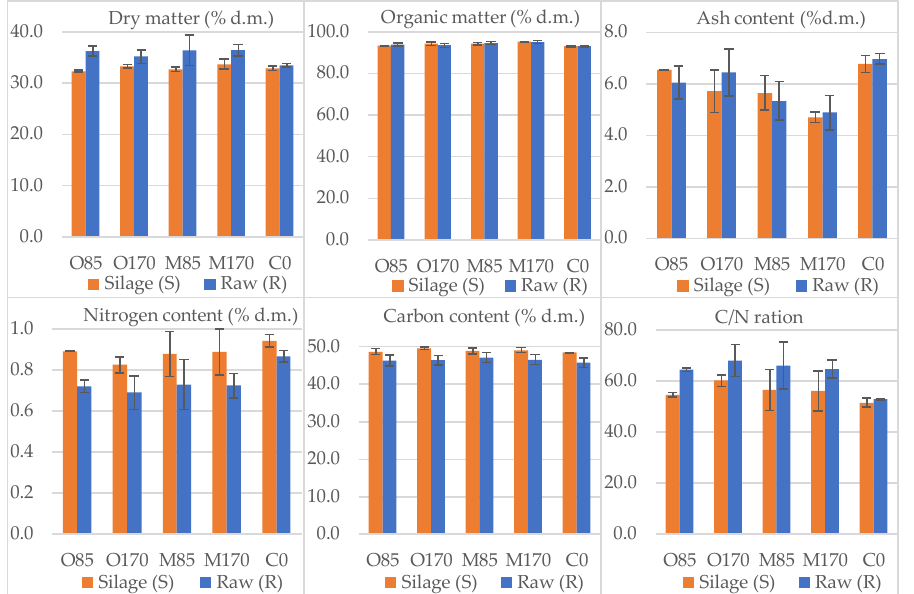
Figure 1. Characteristics of silage and raw material of Helianthus salicifolius used for the preparation of feedstock. (C0—without fertilization; M85—mineral fertilization 85 kg N ha − 1 ; M170—mineral fertilization 170 kg N ha − 1 ; O85—organic fertilization 85 kg N ha − 1 ; O170—organic fertilization 170 kg N ha − 1 ).